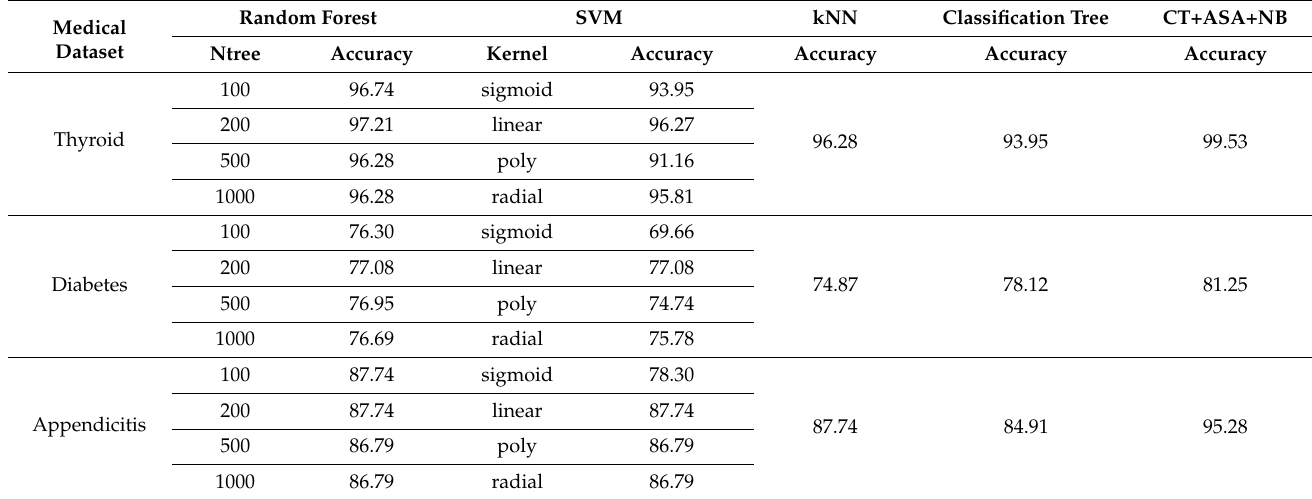
Table 10. LOOCV accuracy (%) for the five methods